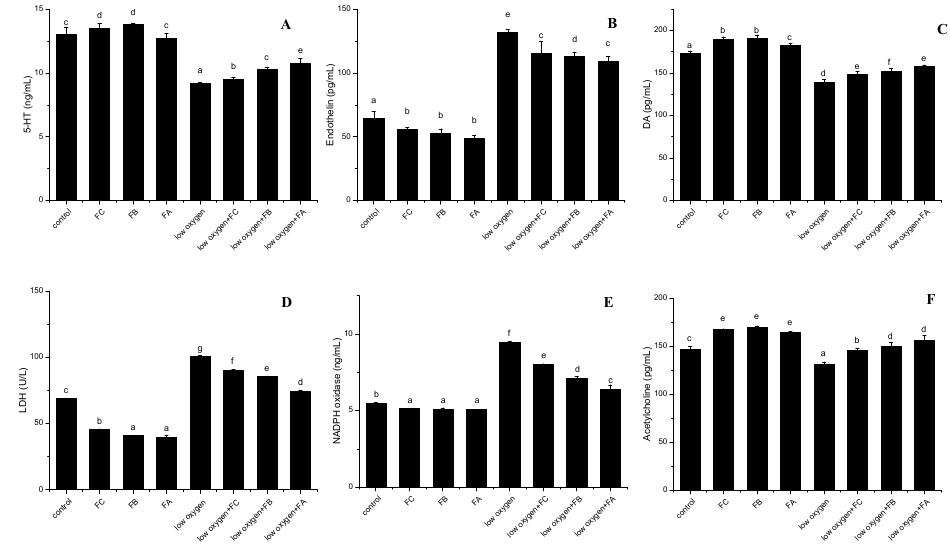
Figure 6. Effects of three polysaccharide fractions ( A – F ) on cell compensation responses under hypoxic